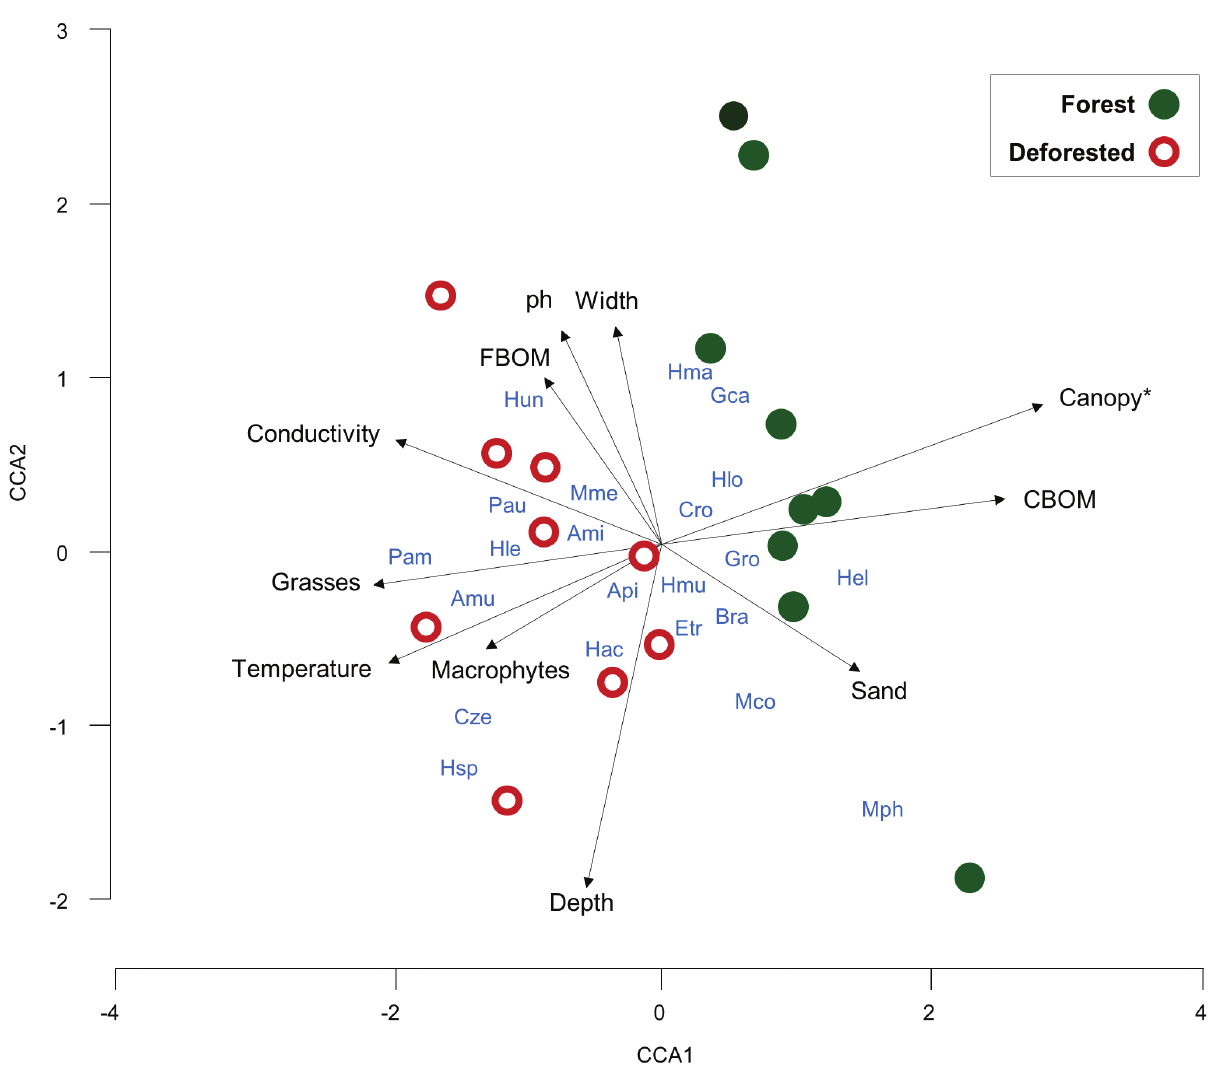
Fig. 5. Diagram of Canonical Correspondence Analysis (CCA) relating 29 fish species (blue letters), 11 environmental variables (black vectors), and 9 sampling sites each in first-order forest streams (solid green circles) and deforested stream reaches (open red circles) in the Upper Xingu River Basin. Species that had only one (singletons), two (doubletons), or three individuals collected were included in the analysis but are not displayed for improved visualization. Environmental variable marked with * was the strongest predictor of fish assemblage’s structure. FBOM = fine benthic organic matter; CBOM = coarse benthic organic matter; Ami = Aequidens michaeli ; Amu = Astyanax multidens ; Api = Apistogramma sp.; Bra = Brachyglanis sp.; Cro = Crenicichla rosemariae ; Etr = Eigenmannia trilineata ; Gro = Gymnorhamphichthys rondoni ; Gca = Gymnotus cf. carapo ; Hac = Hisonotus acuen ; Hel = Helogenes marmoratus; Hle = Hypopygus lepturus; Hlo = Hyphessobrycon loweae ; Hma = Hoplias malabaricus ; Hmu = Hyphessobrycon mutabilis ; Hsp = Hyphessobrycon sp.; Hun = Hoplerythrinus unitaeniatus ; Mme = Melanorivulus megaroni ; Mco = Moenkhausia collettii ; Mph = Moenkhausia phaeonota ; Pam = Pamphorichthys sp.; Pau = Pyrrhulina australis